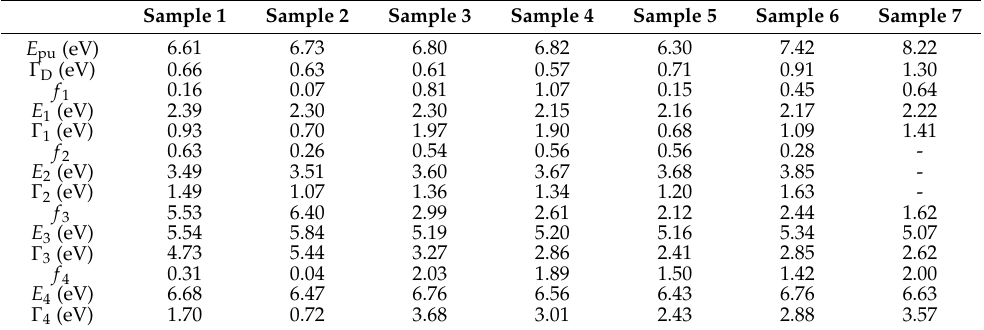
Figure 2. Extracted values of the real ( a , c ) and imaginary ( b , d ) part of the dielectric function in the 193 nm to 1.69 μm ( a , b ) or 1.7 μm to 30 μm ( c , d ) spectral range. Arrows in Figure ( b ) point to the optical transitions. Insets in Figures ( b , d ) show the loss function (minus the imaginary part of the reciprocal dielectric function) as a function of energy. Table 2. Values of all parameters that describe the dielectric function ε of all the samples in the range 193 nm to 1.69 μm.